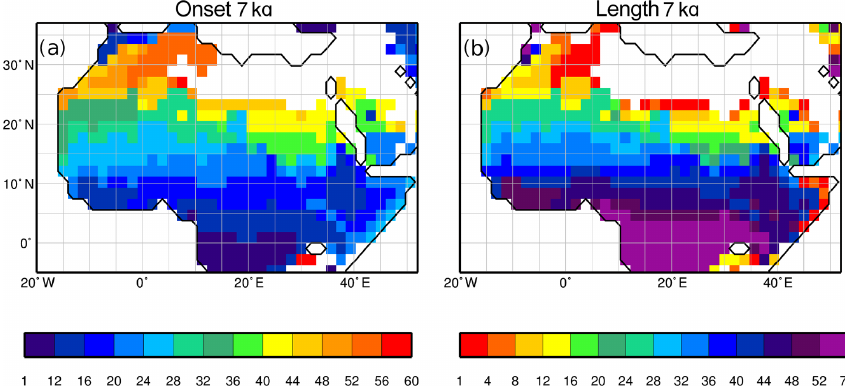
Figure 5. Simulated (a) monsoon onset pentad (i.e. 5d interval) and (b) monsoon length (in pentads) for the 7ka time slice, on land only.